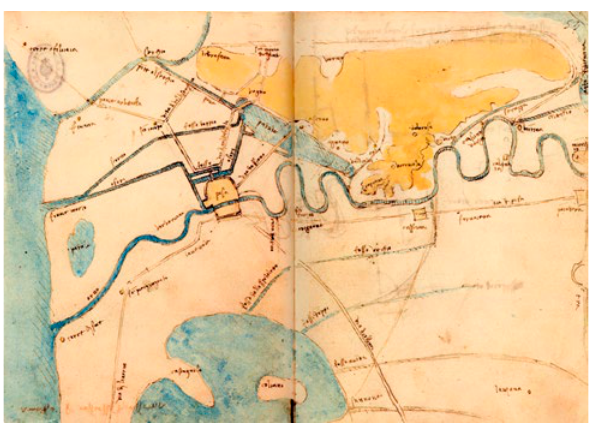
Figure 31. Codex Madrid II, c. 52v-53r: map of the surroundings of Pisa. The place where the deviation of the Arno was carried out is marked as “rotta